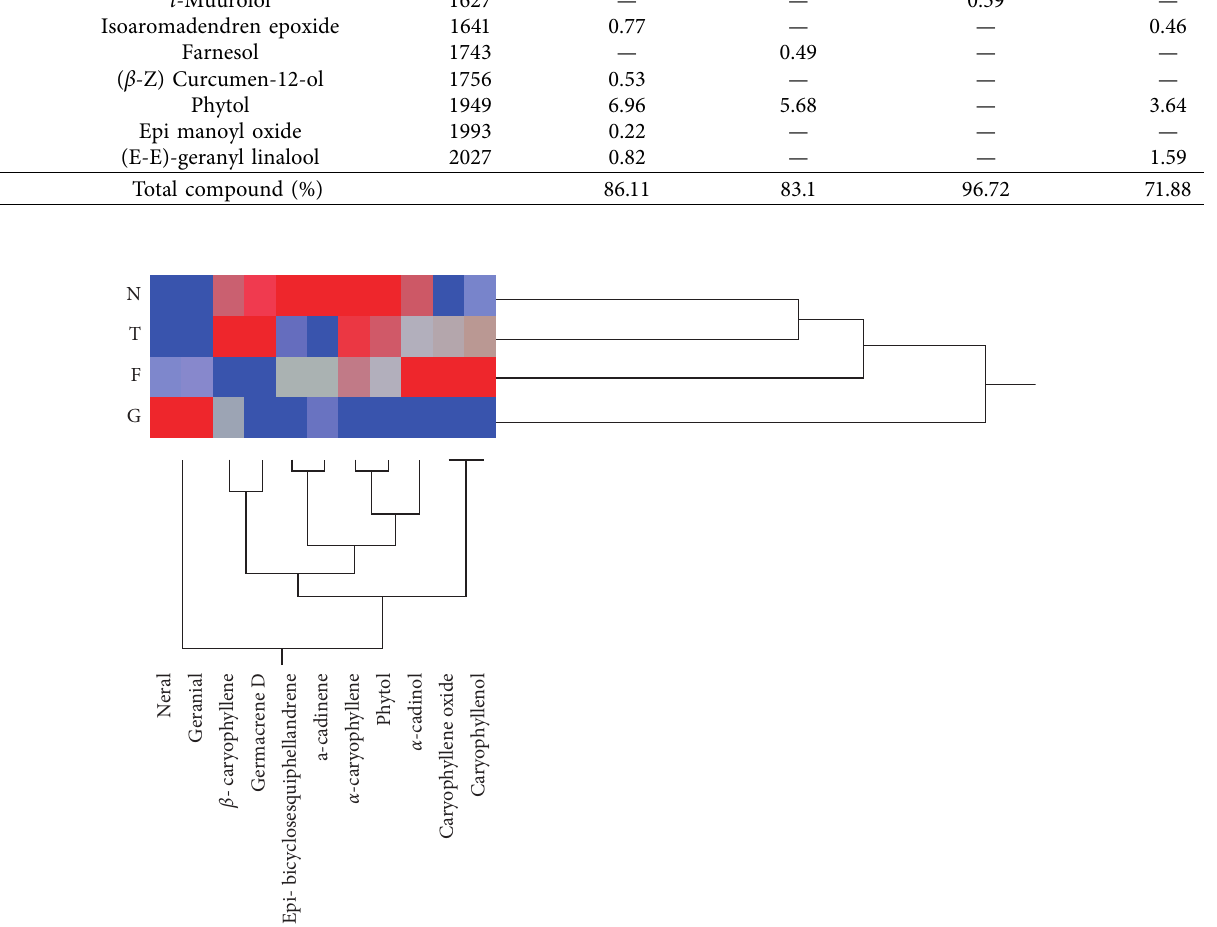
Figure 3: Total phenolic content according to the origin of M. officinalis . N: Nefza, T: Tabarka, F: France, and G: Germany. Table 5: Fatty acid percentage content of M. officinalis leaves. Fatty acid